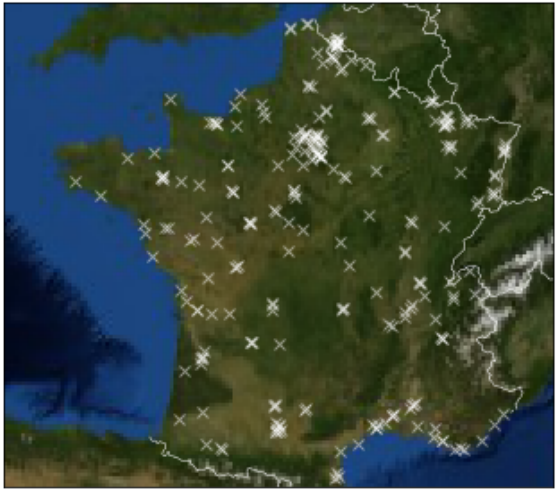
Figure 7. Position of all parkings monitored.